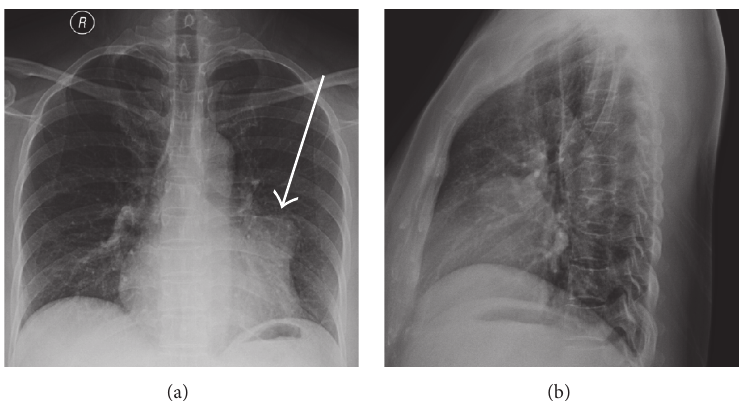
Figure 1: Chest radiography showed small opacity in the left lower lobe (arrow).